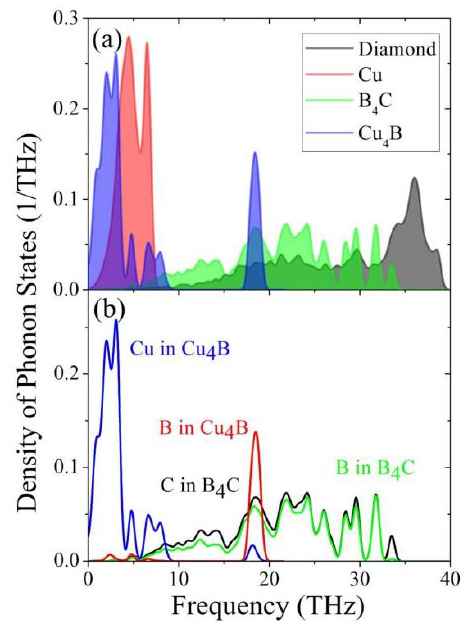
Figure 8. ( a ) Phonon density of states (PDOS) for bulk diamond and Cu, B 4 C compound and Cu 4 B solid solution. ( b ) The contribution for per atom is also